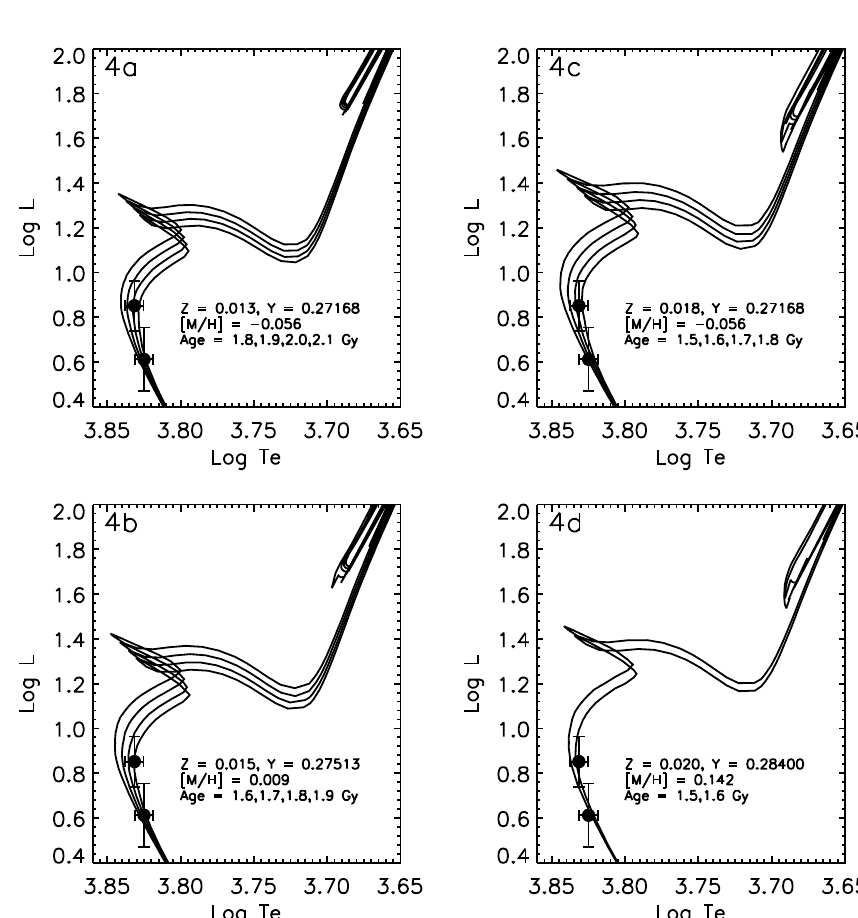
Fig. 4. Components of IO Com in the HR diagram compared with the PARSEC isochrones for the ages between 1.5 and 2.2